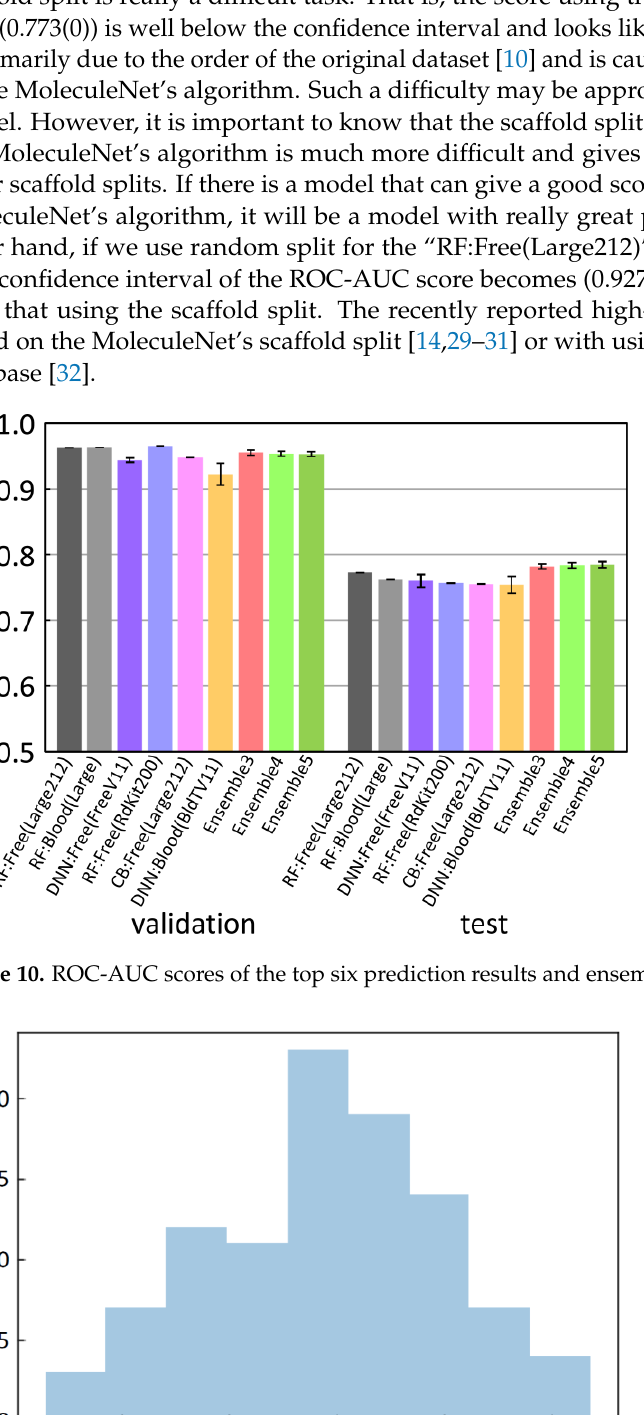
Figure 9. ROC curves for RF:Free(Large212) ( a ), CB:Free(Large212) ( b ), DNN:Free(FreeV11) ( c ), and DNN:Blood(BloodTV11) ( d ).